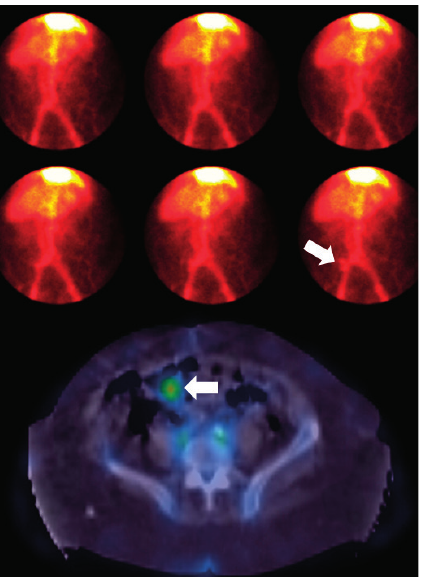
Fig. 9. Bilateral hydronephnosis on CT. The renogram shows no obstruction of the left kidney, with normal function and a good response to furosemide at 20 min. The right kidney has a differential function of only 14% due to obstructive